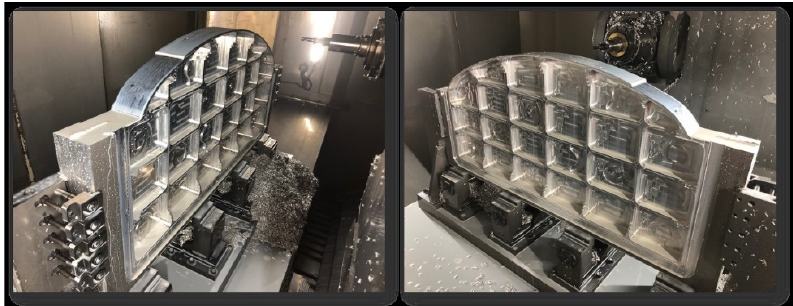
Figure 11. Manufacturing of MPQP test artefacts by NC machining operations.